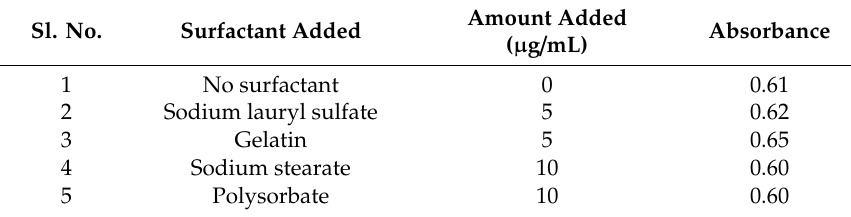
Table 4. E ff ect of surfactants on the absorbance of 30 µ g / mL of